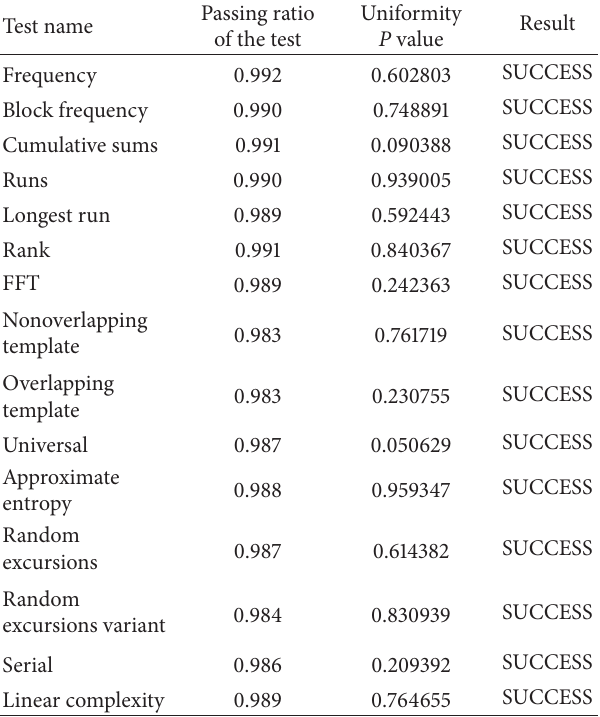
Table 2: The results of the NIST